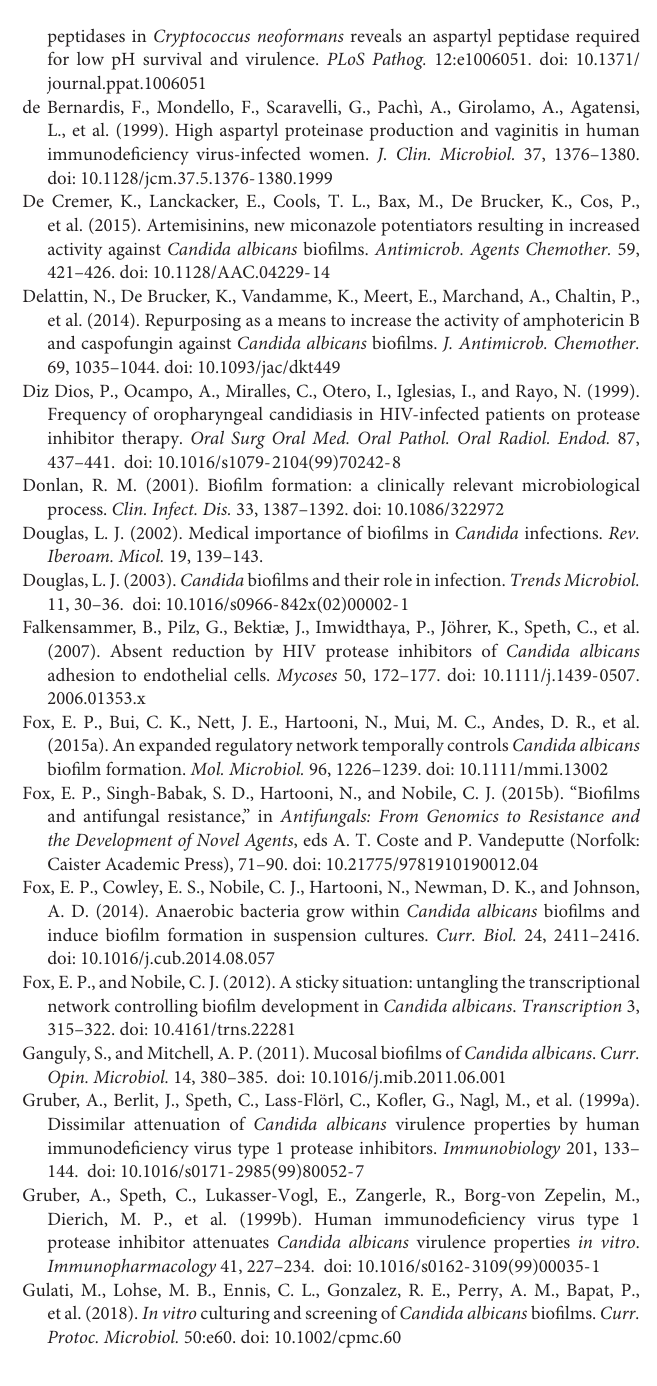
concentration used, average OD 600 , average OD 600 of relevant control(s), and value(s) for Welch’s t -test versus the relevant control(s) are provided. Whether the average OD 600 was below the average OD 600 of the relevant control(s) and whether the difference from the relevant control(s) remains significant following the Bonferroni Correction ( α = 0.05) are also indicated. The sensitivity of SNY425 to amphotericin B, caspofungin, and fluconazole in planktonic and biofilms assays are also indicated. A list of the 80 compounds from the three protease inhibitor libraries tested in this study and a summary of the hits from the standalone and combination Sustained Inhibition and Disruption Optical Density Biofilm Assays are also